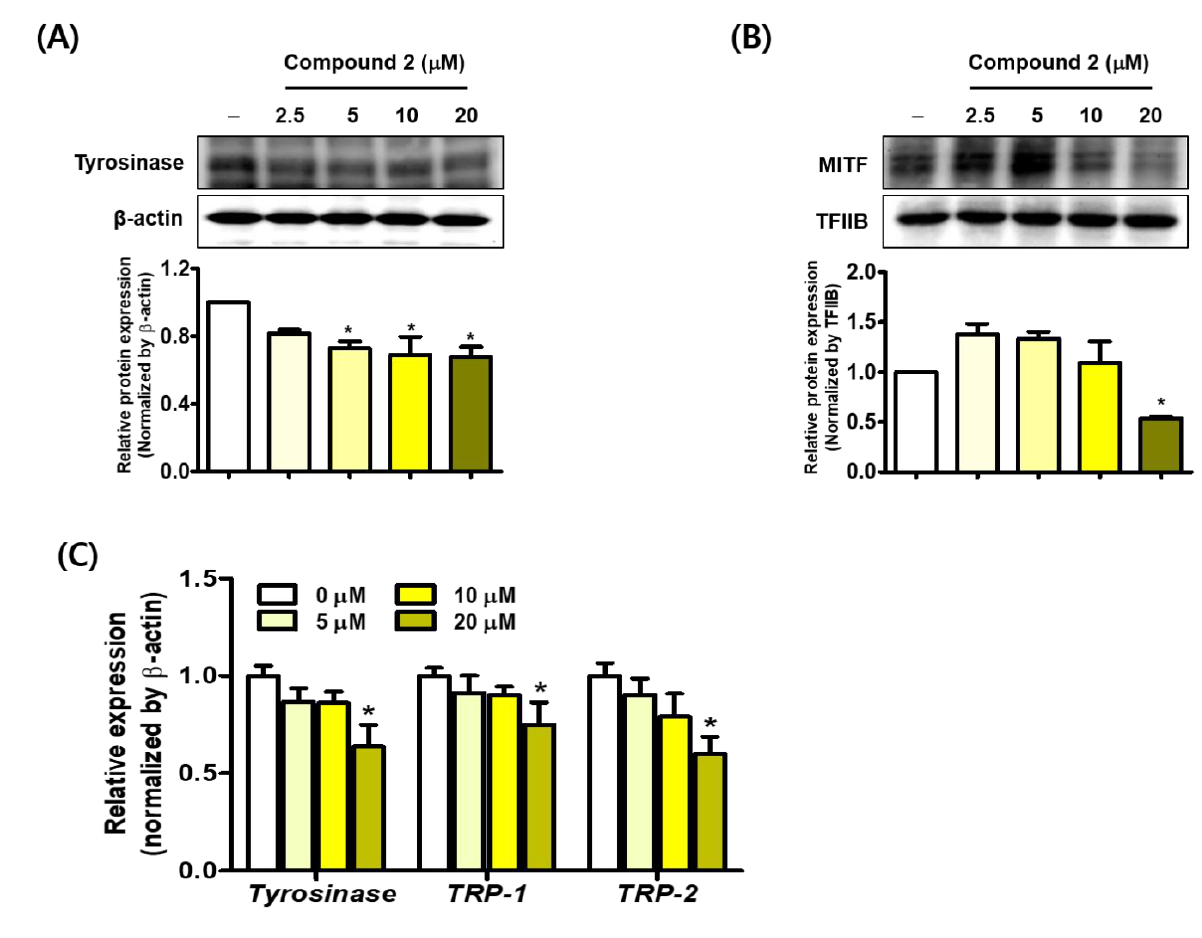
Figure 14. The effect of analog 2 on melanogenesis-associated transcriptional events. Protein levels of tyrosinase and MITF in analog 2 -treated B16F10 cells were determined by western blotting cytosolic ( A ) and nuclear fractions ( B ) from total lysates of B16F10 cells. β -Actin and TFIIB were used as loading controls for cytosolic and nuclear fractions, respectively. ( C ) The mRNA expressions of tyrosinase , TRP-1 , and TRP-2 in cells treated with analog 2 were determined by qRT-PCR using β -actin mRNA as an internal control. Primer sets are detailed in Table 1. Data are presented as means ± SEMs. * indicates significant differences between columns: * p < 0.05 for cells treated with analog 2 versus non-treated controls. Experiments were performed independently three times.